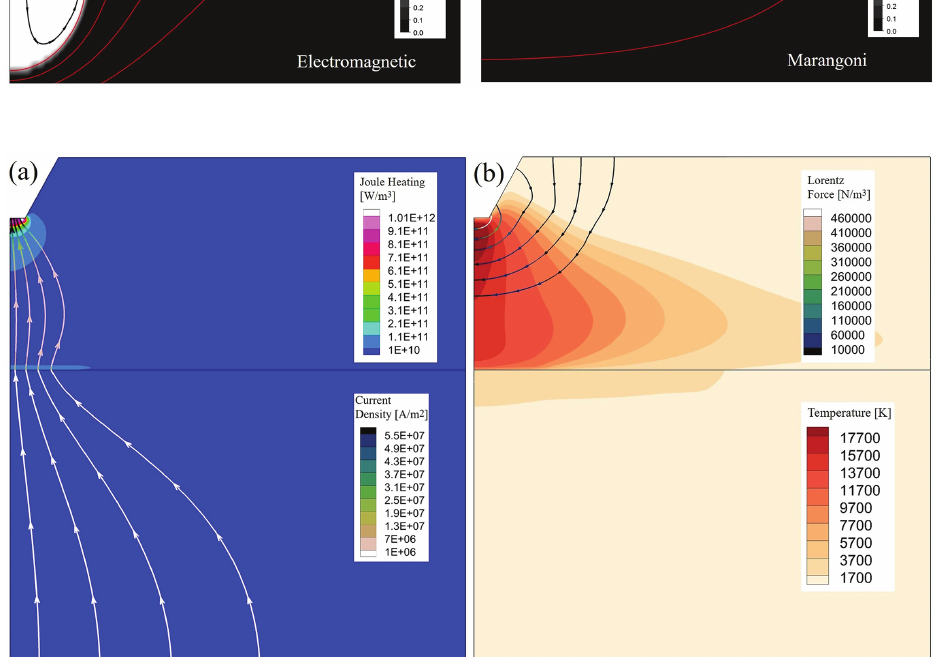
Figure 8: (a) Current density and Joule heating, (b) Lorentz force and temperature fields of the unified